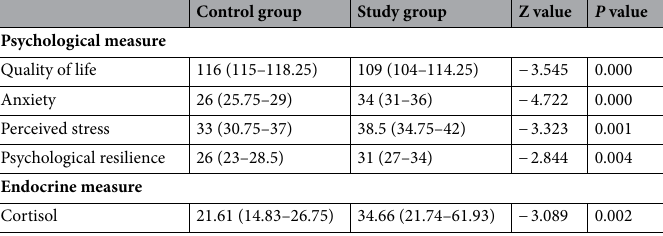
Table 2. Comparison of psychological stress and hair cortisol between control and study